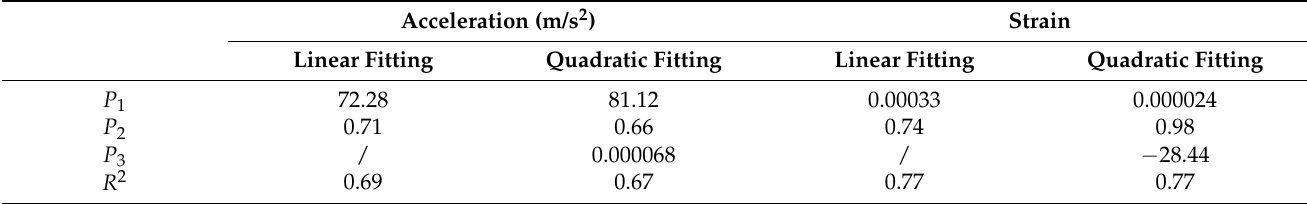
Table 4. Fitting coefficients and adjusted R 2 under different parameters.